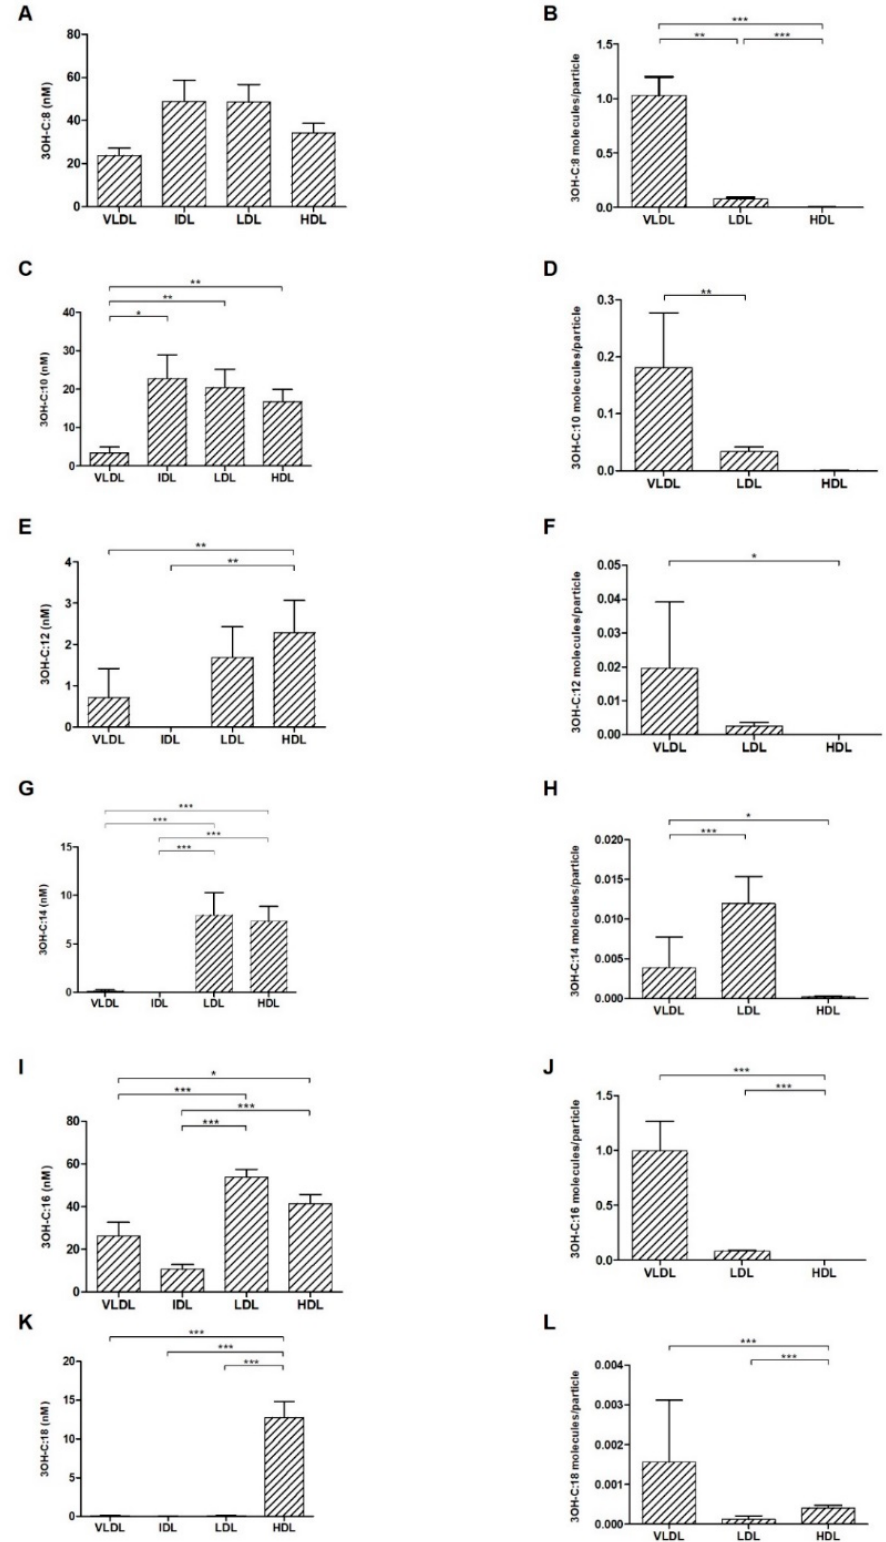
Figure 2. Mean concentration (nM) of each LPS-derived 3OHFA, namely 3OH-C:8 ( A ), 3OH-C:10 ( C ), 3OH-C:12 ( E ), 3OH-C:14 ( G ), 3OH-C:16 ( I ) and 3OH-C:18 ( K ) in VLDL, IDL, LDL and HDL fractions. Mean 3OHFA/particle ratio of 3OH-C:8 ( B ), 3OH-C:10 ( D ), 3OH-C:12 ( F ), 3OH-C:14 ( H ), 3OH-C:16 ( J ) and 3OH-C:18 ( L ) in VLDL, LDL and HDL fractions. * p < 0.05, ** p < 0.01 and *** p < 0.001.